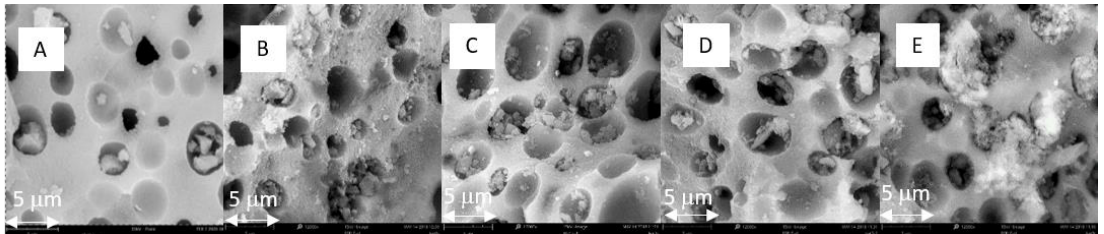
Figure 6. SEM images of [mtespim]Cl/@SiO 2 : ( A ) fresh; ( B ) after the first cycle; ( C ) after the second cycle; ( D ) after the third cycle; ( E ) after the fourth cycle.